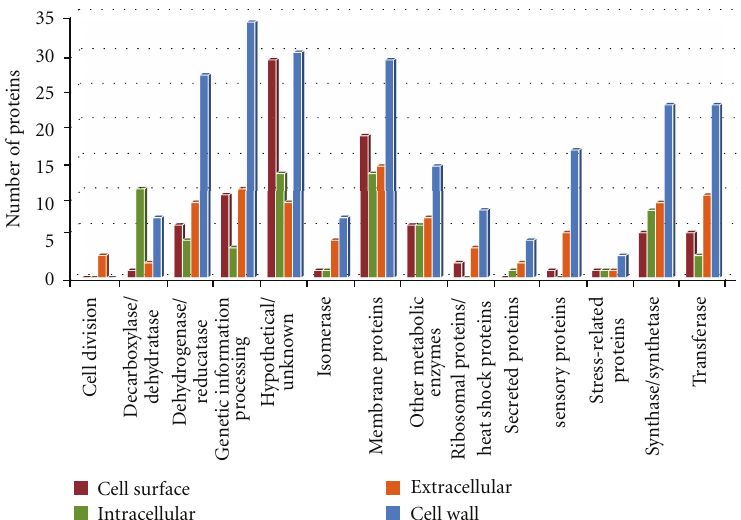
Figure 4: Distribution of proteins belonging to di ff erent functional classes found specific to only one cellular fraction of B. vietnamiensis G4.